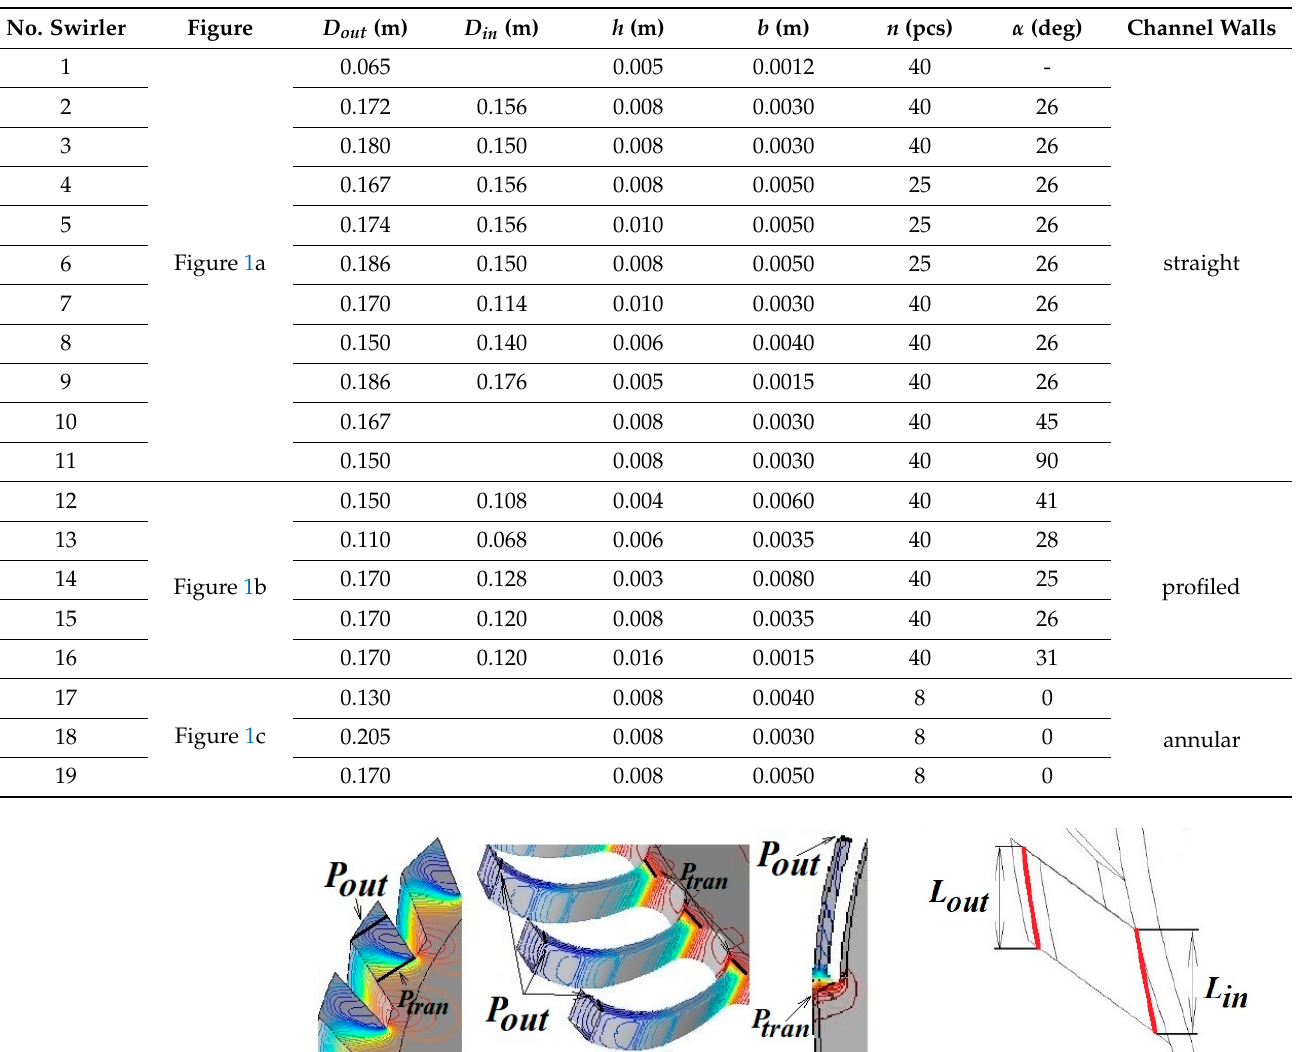
Table 1. Parameters of the studied swirlers.